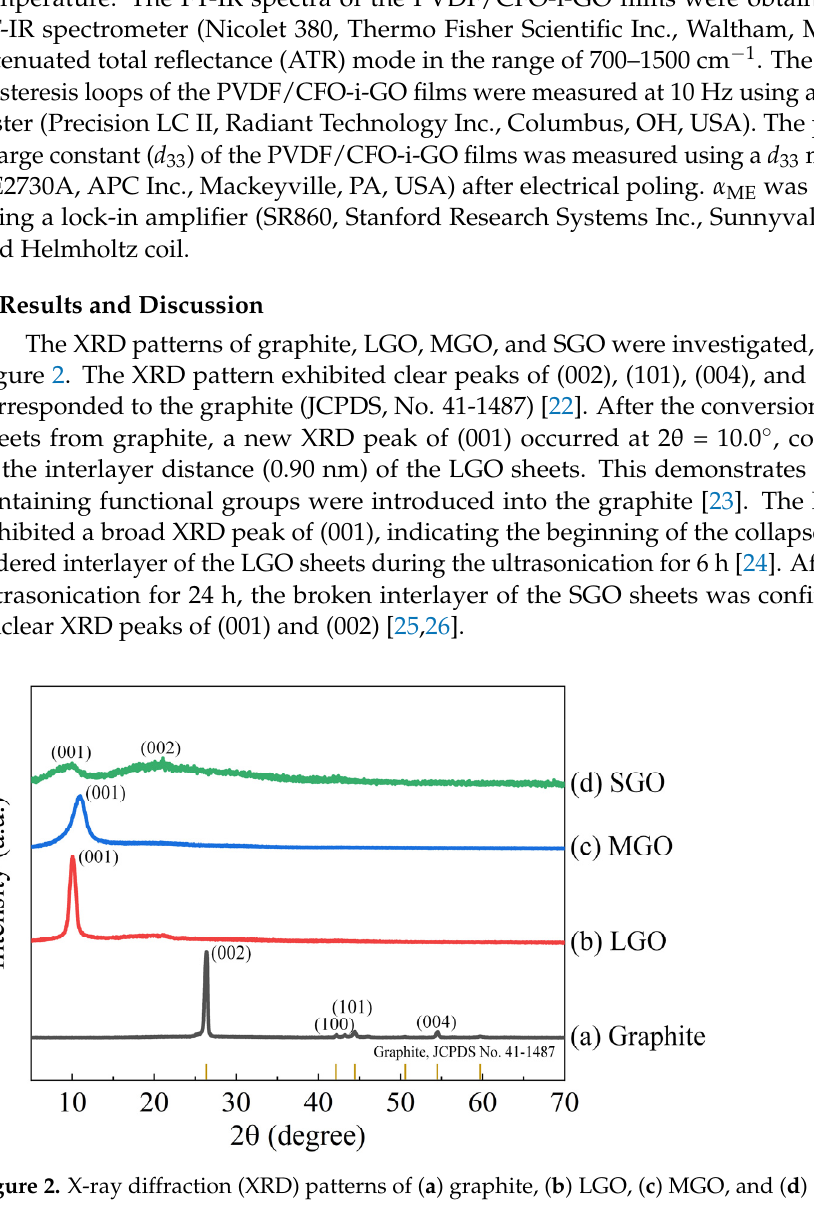
Figure 3. Representative scanning electron microscope (SEM) images of the ( a ) LGO, ( c ) MGO, and ( e ) SGO sheets. Inset data; box plots of the lateral size of the LGO, MGO, and SGO sheets. Dynamic light scattering (DLS) analysis of the lateral size distribution of the ( b ) LGO, ( d ) MGO, and ( f ) SGO sheets.